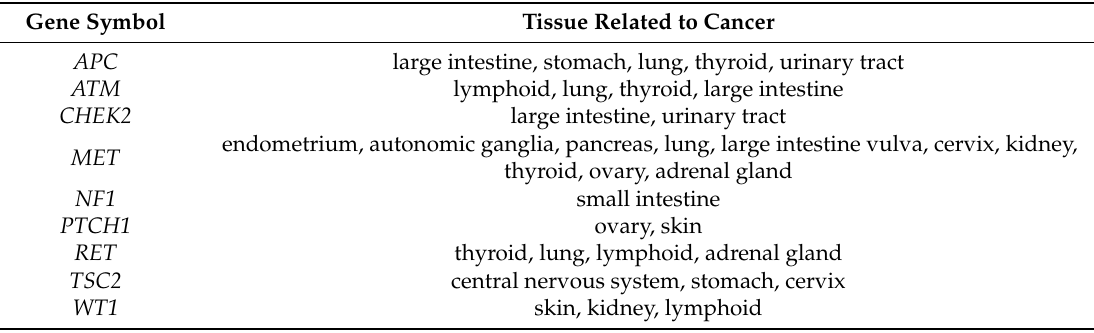
Table 3. COSMIC results for 65 nonsynonymous variants identified from